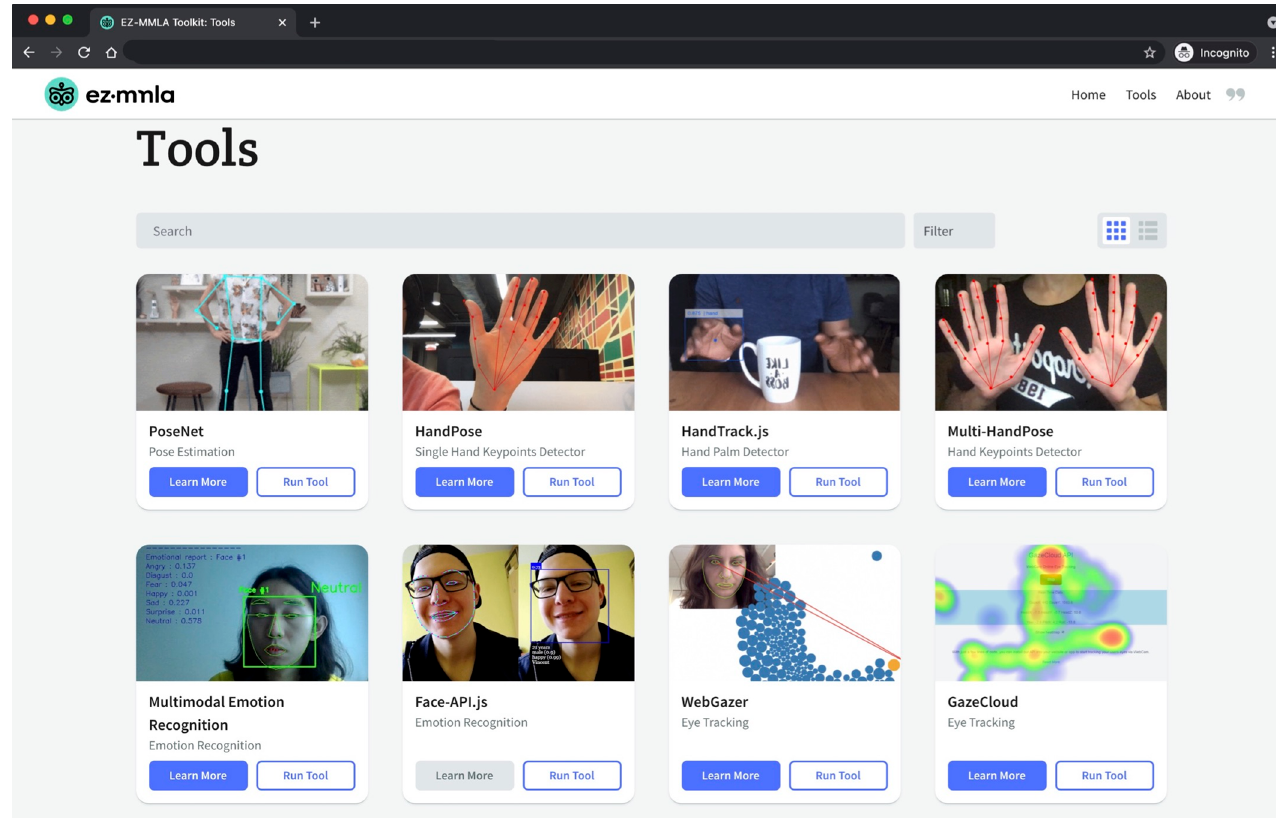
Figure 3. The Tools page of the EZ-MMLA toolkit. This page consists of a list of tools available for multimodal data collection. Each tool contains a link to start running the tool and a link to learn more about how the tool works. Figure 4 shows the page for running PoseNet, which opens up when the user clicks on the “run tool” button.